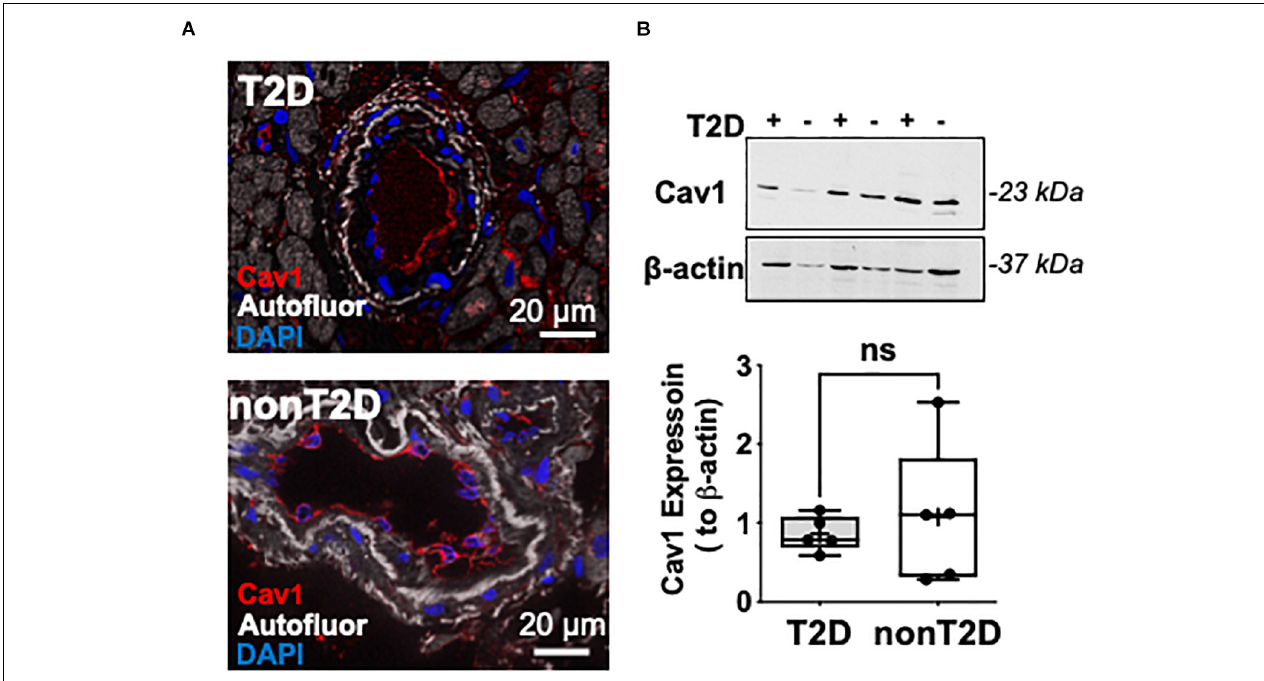
FIGURE 2 | Representative microphotographs of immunofluorescent staining for Caveolin-1 (shown in red) in coronary arterioles from T2D and non-diabetic patients (A) . Nuclei were stained with DAPI (blue). Autofluorescence is shown in white. Scale bar = 20 µ m. Representative images of Western immunoblot and summary data for protein expression of Cav-1 and β -actin in coronary arterioles obtained from T2D ( n = 3) and non-diabetic ( n = 3) patients (B) .